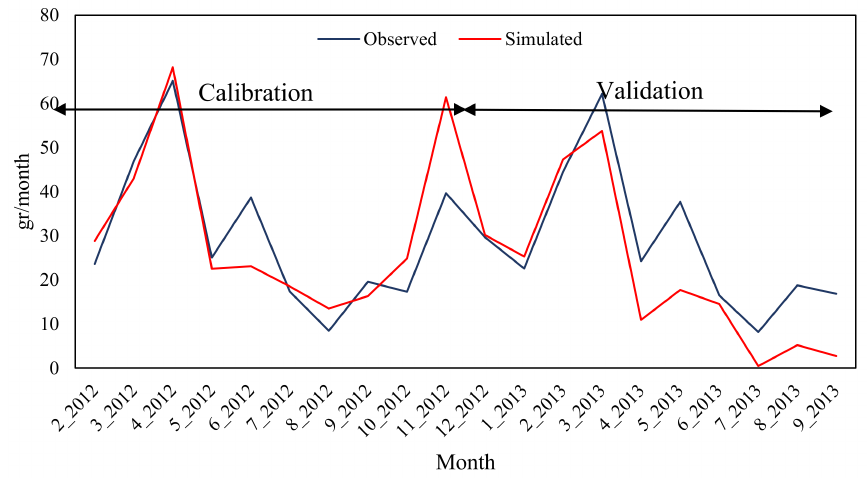
Figure 7. Observed and simulated monthly nitrate load for calibration and validation periods during 2012–2013 passing through the cross-section of Shirgah